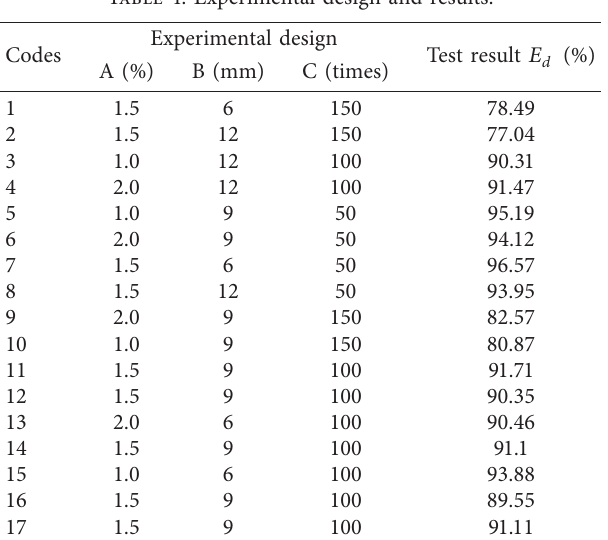
Table 4: Experimental design and results.